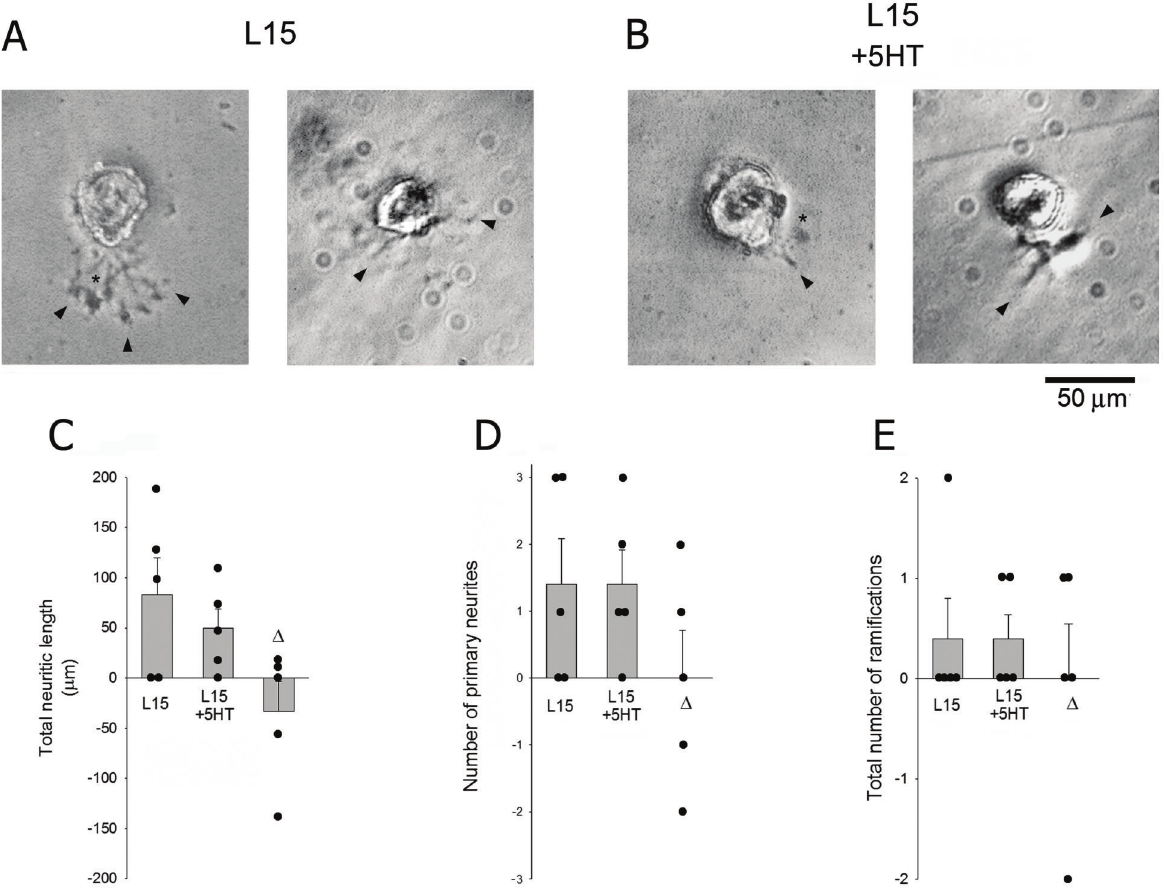
Figure 4. Effect of serotonin (5-HT) on the morphological pattern of annulus erector (AE) motoneurons. A , AE motoneurons yielded few short and thick primary neurites (black arrowheads), with some rami fi cations and lamellipodia (asterisks). B – E , The presence of serotonin in the medium did not modify the morphological parameters. D denotes the average difference ( ‘ with 5HT ’ minus ‘ without 5HT ’ ) for each pair of neurons from the same experiment. No statistical signi fi cance was found with the unpaired t -test. Data are reported as means ±